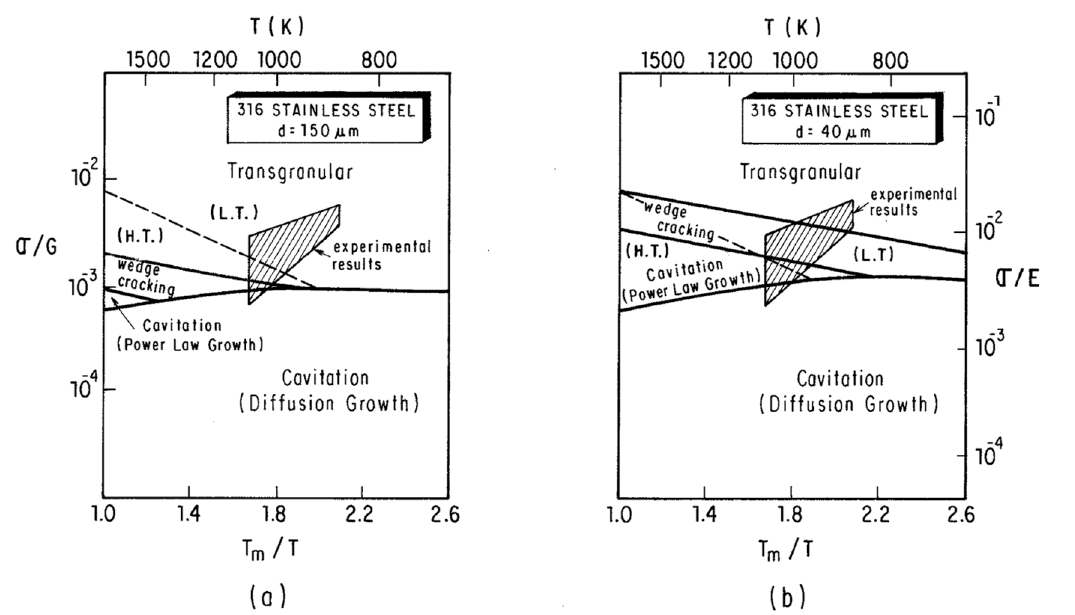
Figure 7. Model-based fracture maps for AISI type 316 stainless steel with grain sizes of (a) 150 μm and (b) 40 μm (Adapted from Miller and Langdon 8 ). Present experimental results are indicated. ductility transgranular fracture to a low ductility intergranular wedge cracking fracture with decreasing temperature and increasing stress. This kind of transition occurred in both SS1 and SS2 316 steels, as experimentally observed in Fig. 1 to 4 for their creep fracture behavior.